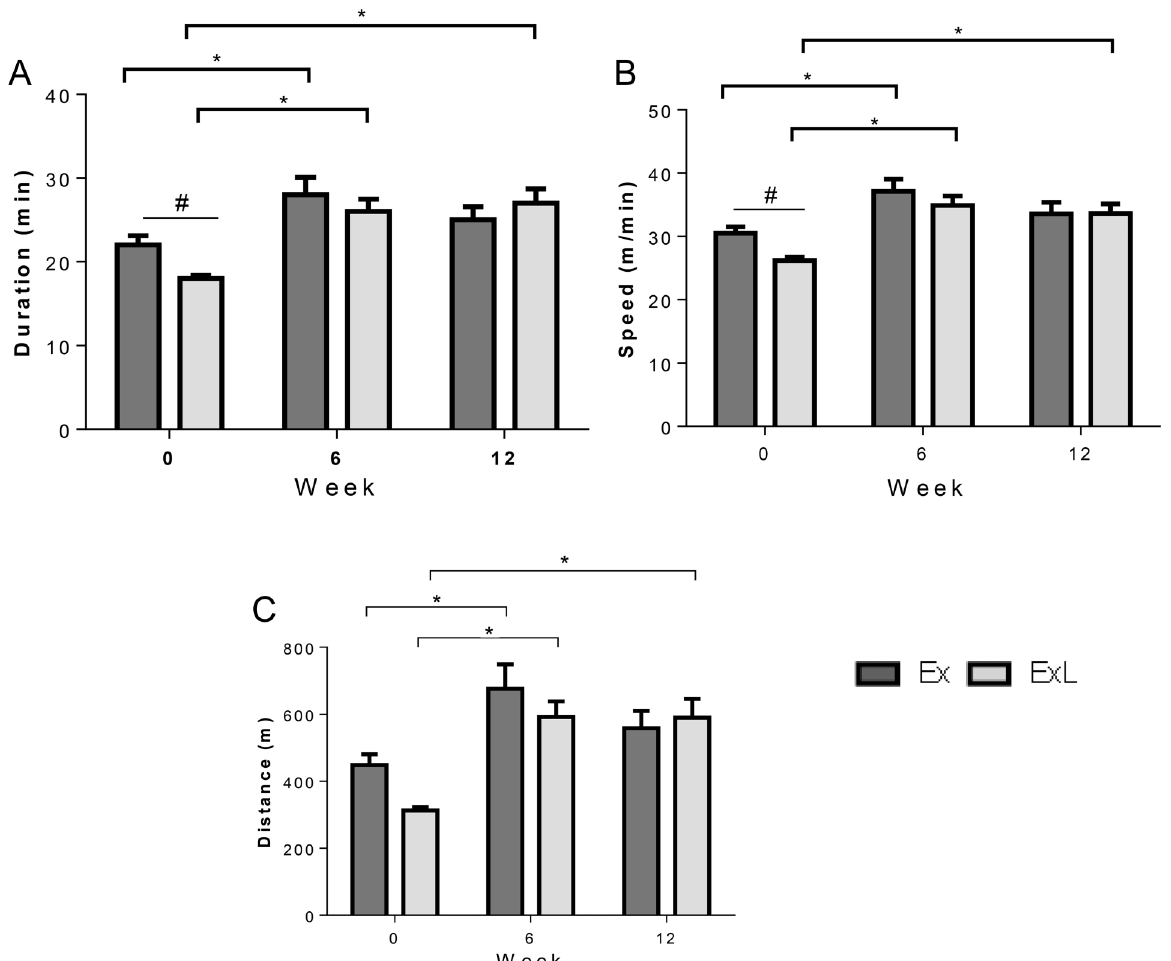
Figure 2. Maximum running speed test performed in exercised groups. Ex: chronic aerobic exercise (n=14) and ExL: chronic aerobic exercise and low-dose administration of L-NAME (n=16). Data are reported as mean ± SEM. *P o 0.05, vs 0 week; # P o 0.05, Ex vs ExL (one-way ANOVA followed by Tukey ’ s post hoc